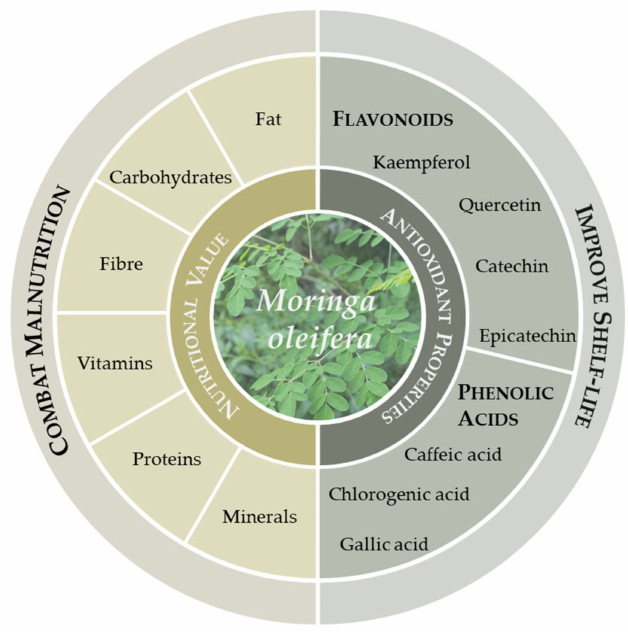
Figure 2. Moringa oleifera properties useful to food fortification.